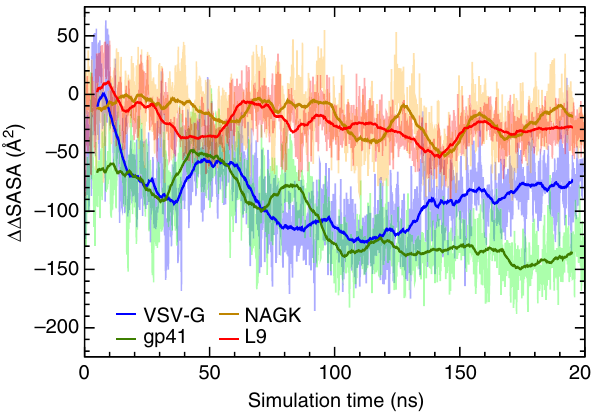
Fig. 2 Solvent accessible surface area (SASA) for folded versus extended states. Effect of ribosome on solvent accessible surface area (SASA) of hydrophobic residues within the α -helical sequences for folded versus extended states. ΔΔ SASA = Δ SASA folded – Δ SASA extended (see Methods for the de fi nition of Δ SASA). Negative ΔΔ SASA values indicate that the ribosome is stabilizing hydrophobic regions of the helical sequence in the folded, α -helical (compact) state more than in the extended state. Conversely, positive values indicate that the ribosome is stabilizing